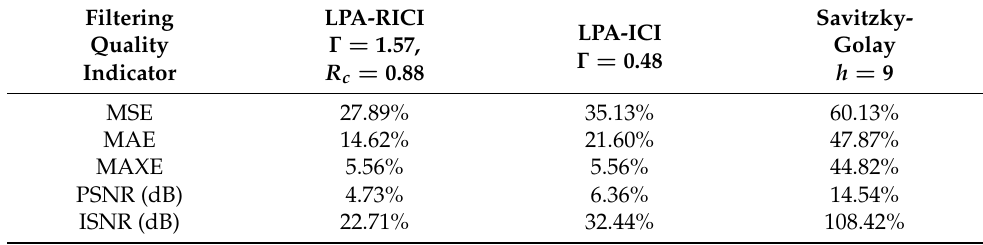
Table 12. Bumps signal (SNR = 7 dB)—Filtering quality improvement of the RBF-RICI-based filtering over other tested algorithms.